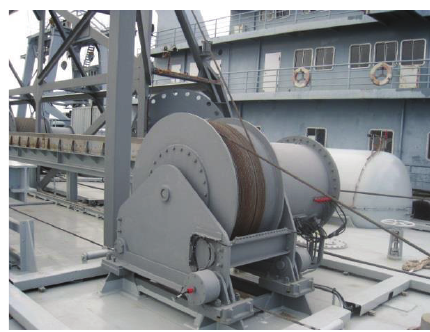
Figure 24: Underwater hydraulic winch.